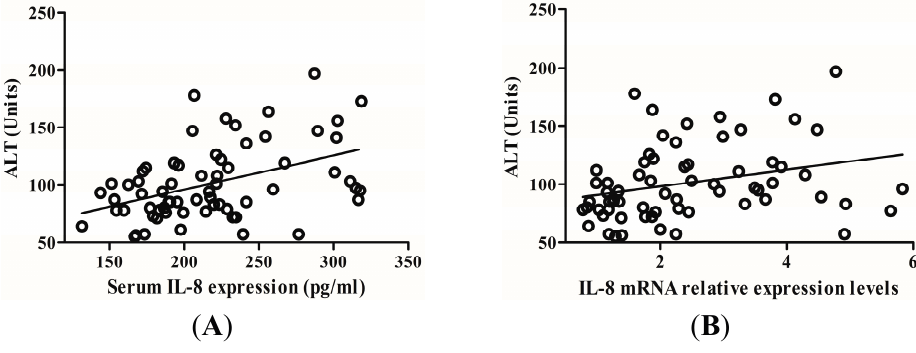
mRNA was also positively correlated with serum ALT levels.